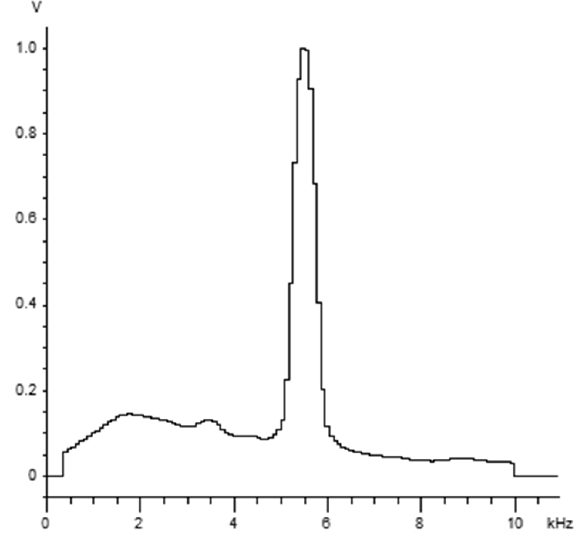
Figure 4. Power spectrum of an advertisement call of Choero- phryne crucifer sp. n